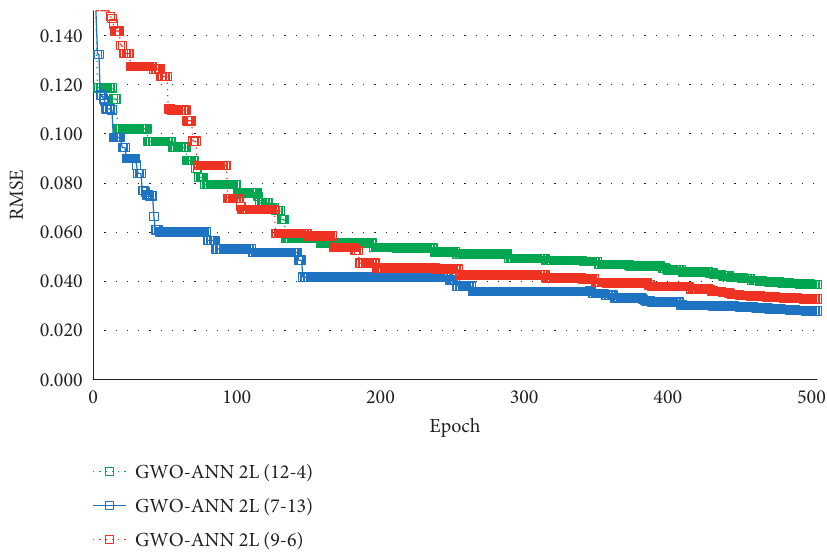
Figure 6: RMSE for the top three models for GWO-ANN models.